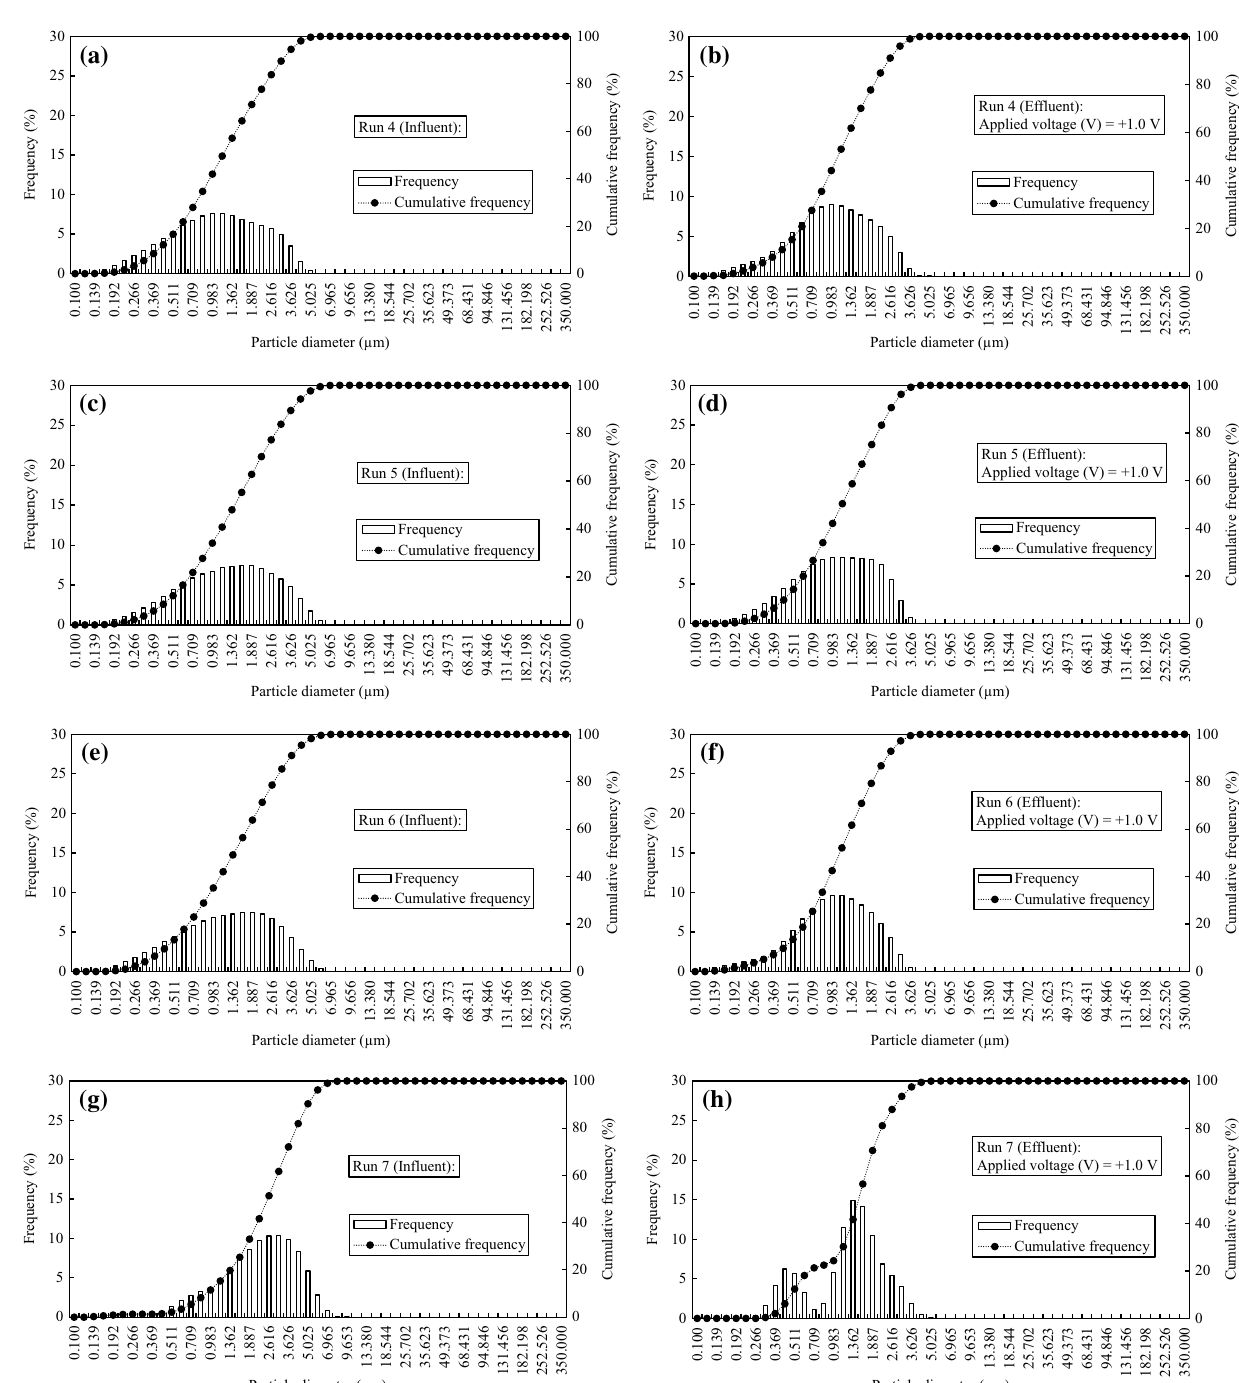
Fig. 6 a – n Volume-based kaolin suspension particle size distribution of influent and effluent of Runs 4–10, where synthetic contaminated source water (Table 2) was used as a solvent in Runs 4 and 5. Sodium